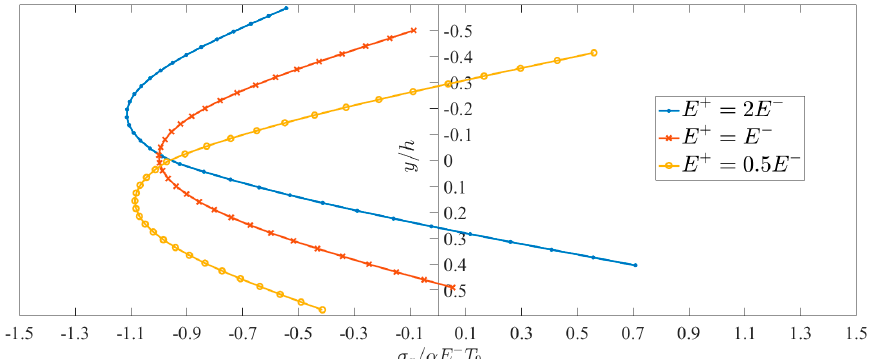
Figure 7. The total stress when α E − T 0 / q = 20.